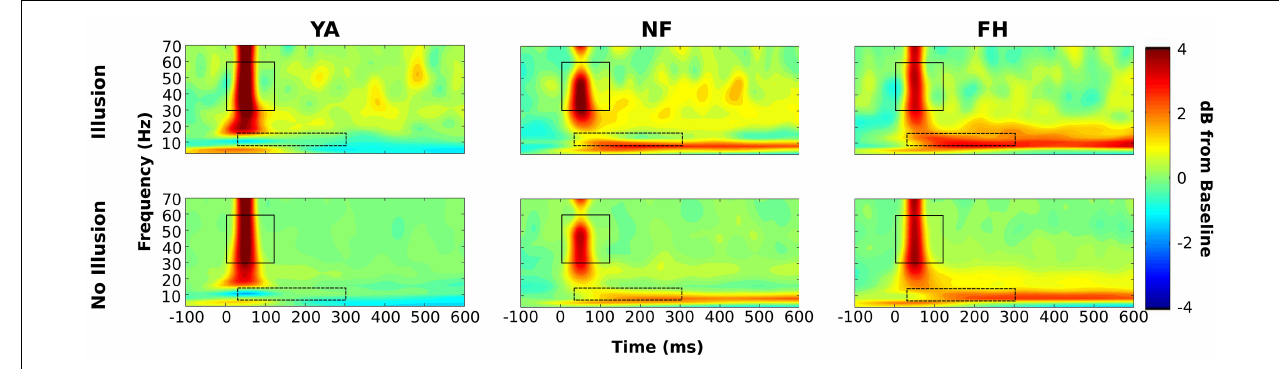
FIGURE 5 | Time-frequency plots combined across SOA type. Group-averaged time-frequency representations are displayed for illusion (top row) and no illusion (bottom row) conditions combined across the 30, 70, and 150 ms SOA levels. Timepoint 0 ms represents the onset of the flash-beep pair and power spectra are displayed as the decibel (dB) change from the average –500 to –200 baseline period. Group level time frequency windows are shown for gamma (solid boxes) and alpha (dashed boxes). Power values are displayed in dB.